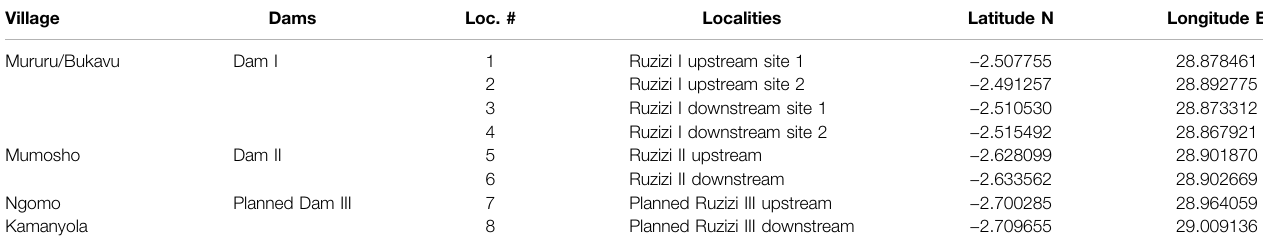
TABLE 1 | Locality information with the villages where Dam I and Dam II are located and coordinates of sampling sites upstream and downstream of the